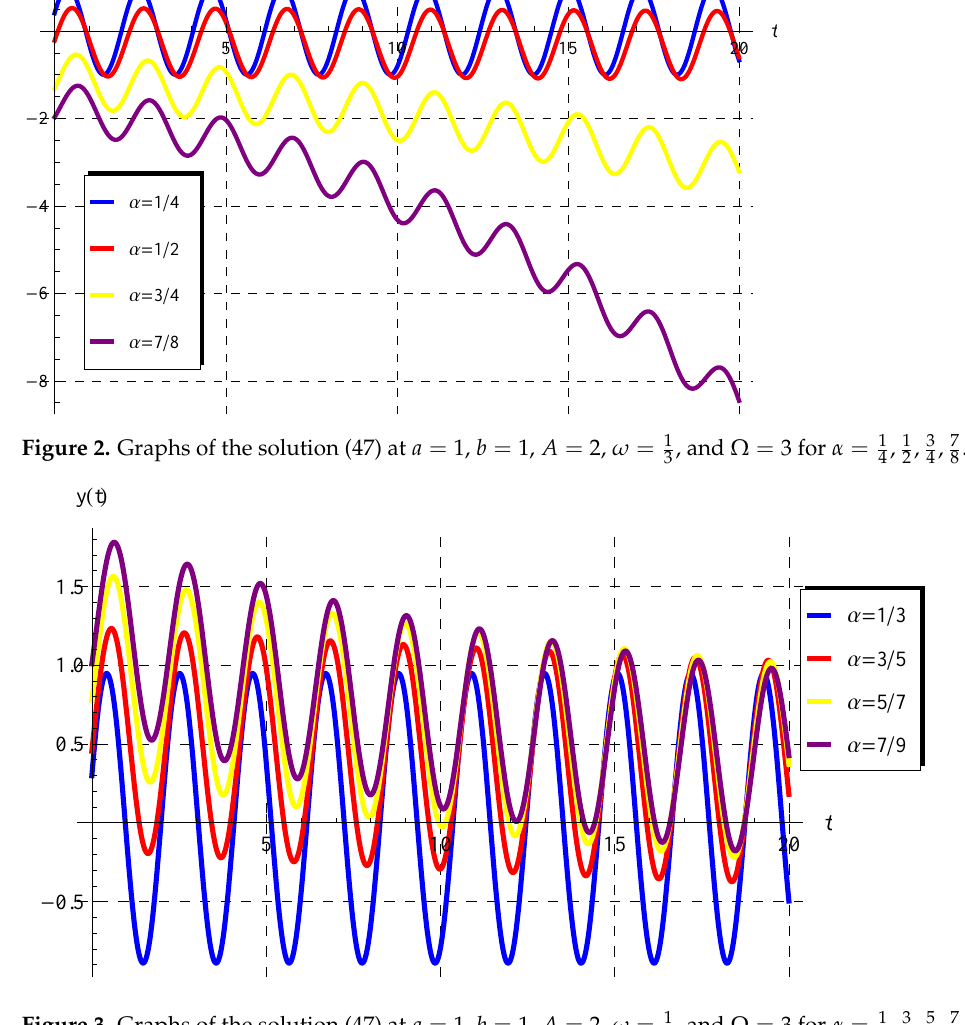
, and Ω = 3 for α = 1 3